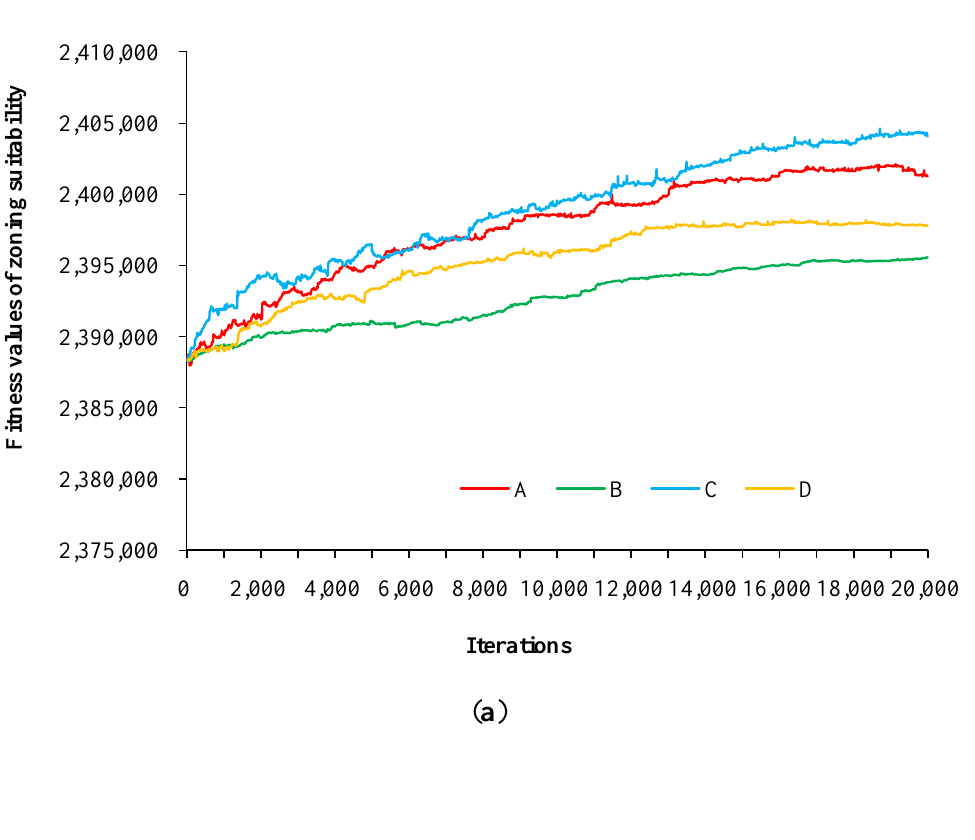
Figure 5. Convergence curves of ( a ) the zoning suitability and ( b ) planning compatibility